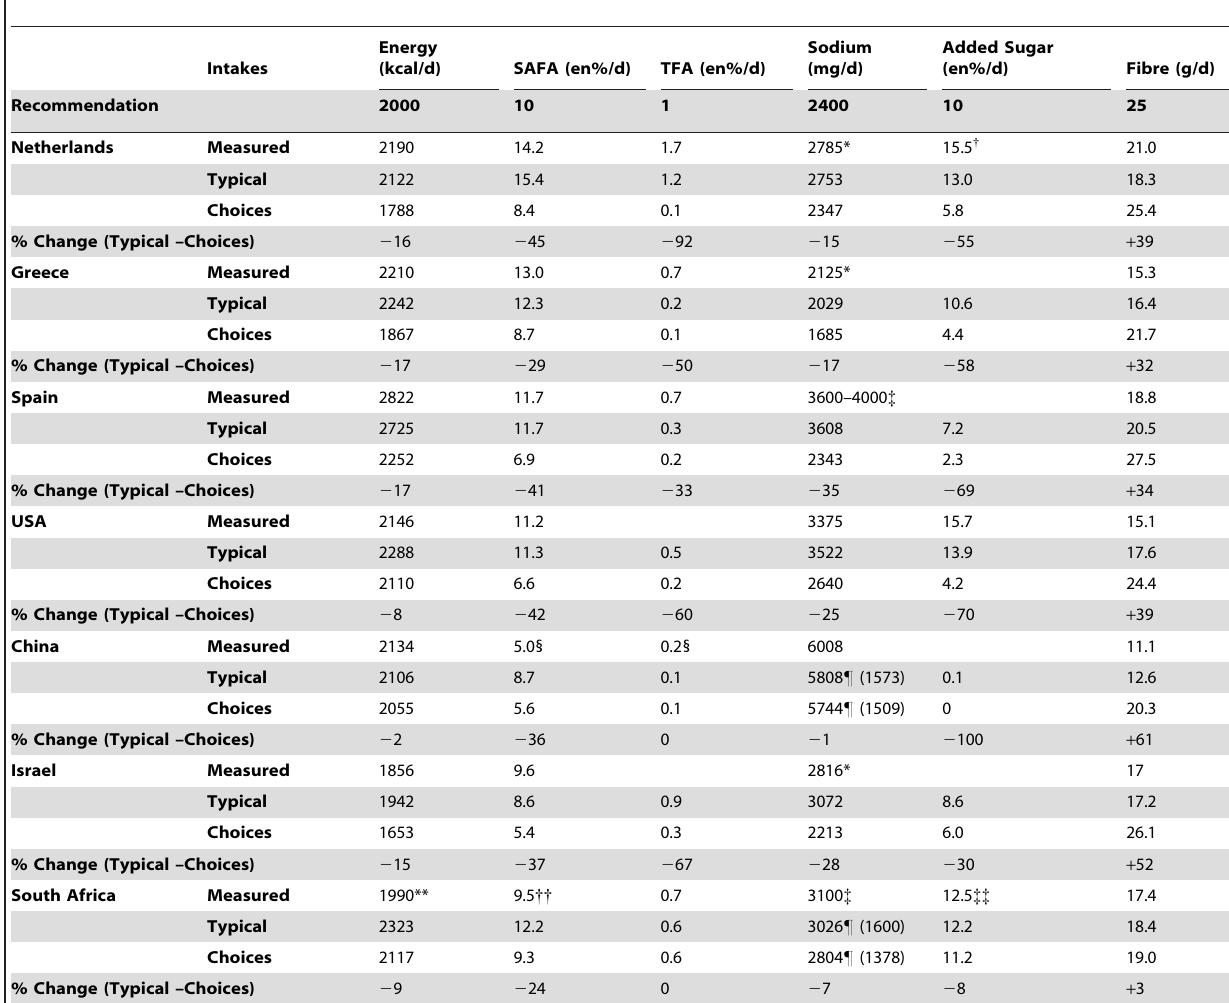
Table 4. Overview results: Potential impact of Choices Programme on nutrient intakes as calculated by the Daily Menu Method (based on 3 daily menus) for 7